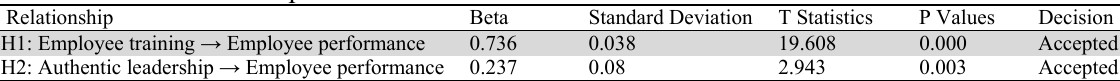
Result of direct relationship